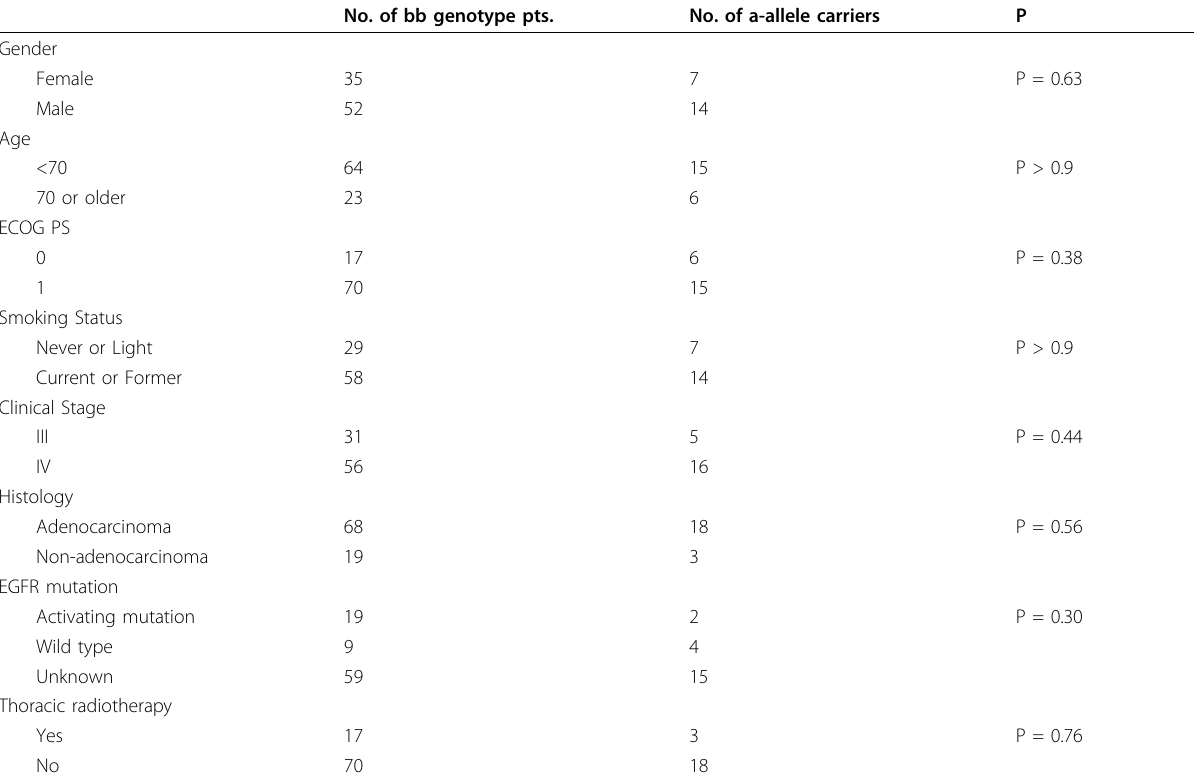
Table 4 Comparative analysis of demographic and pathological information No. of bb genotype pts.